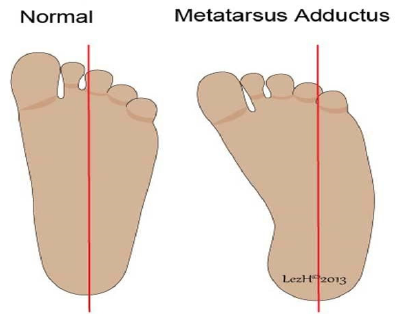
Figure 1. Metatarsus adductus as an example of deformation due to intrauterine positioning or space constraints.